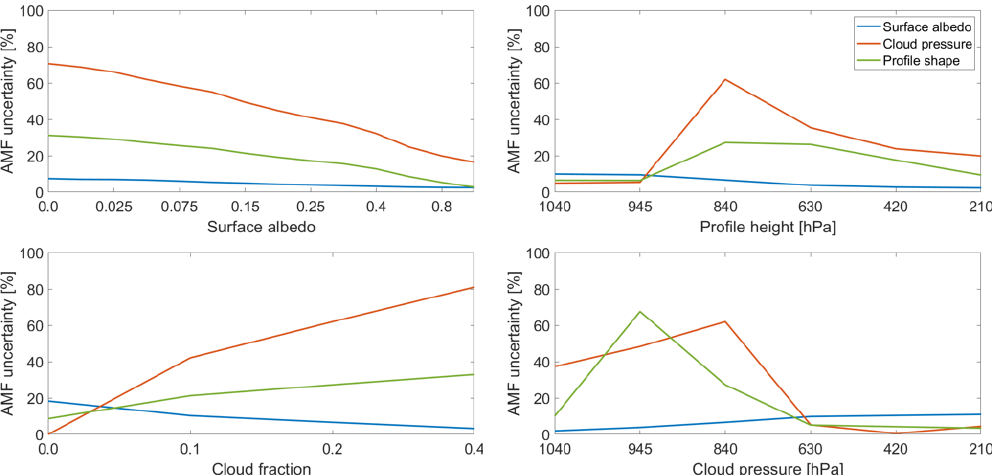
Figure 20. Tropospheric AMF uncertainties related to the surface albedo, cloud pressure, and a priori NO 2 profile errors. By default, the surface pressure is 1050hPa, the surface albedo is 0.05, the profile height is 840hPa, the cloud pressure is 840hPa, and the cloud fraction is 0.2. The definition of profile height is given in the